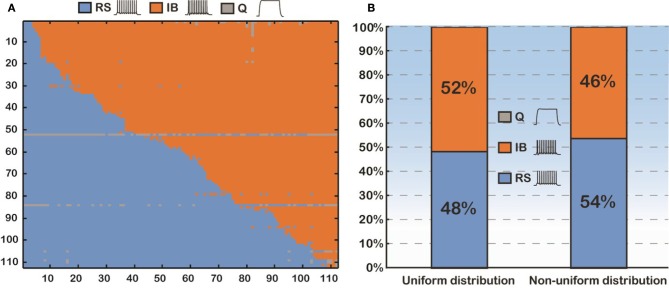
(A) Confusion matrix of 12544 (112 × 112) combinations of dendritic trees (basal and apical) sorted according to the firing pattern of the model cells. (B) Proportions of the model cells' firing behavior (RS vs. IB). Uniform distribution means that the conductance of an active mechanism is not dependent on the distance from the soma. Non-uniform distribution means the conductance of an active mechanism is distance-dependent.